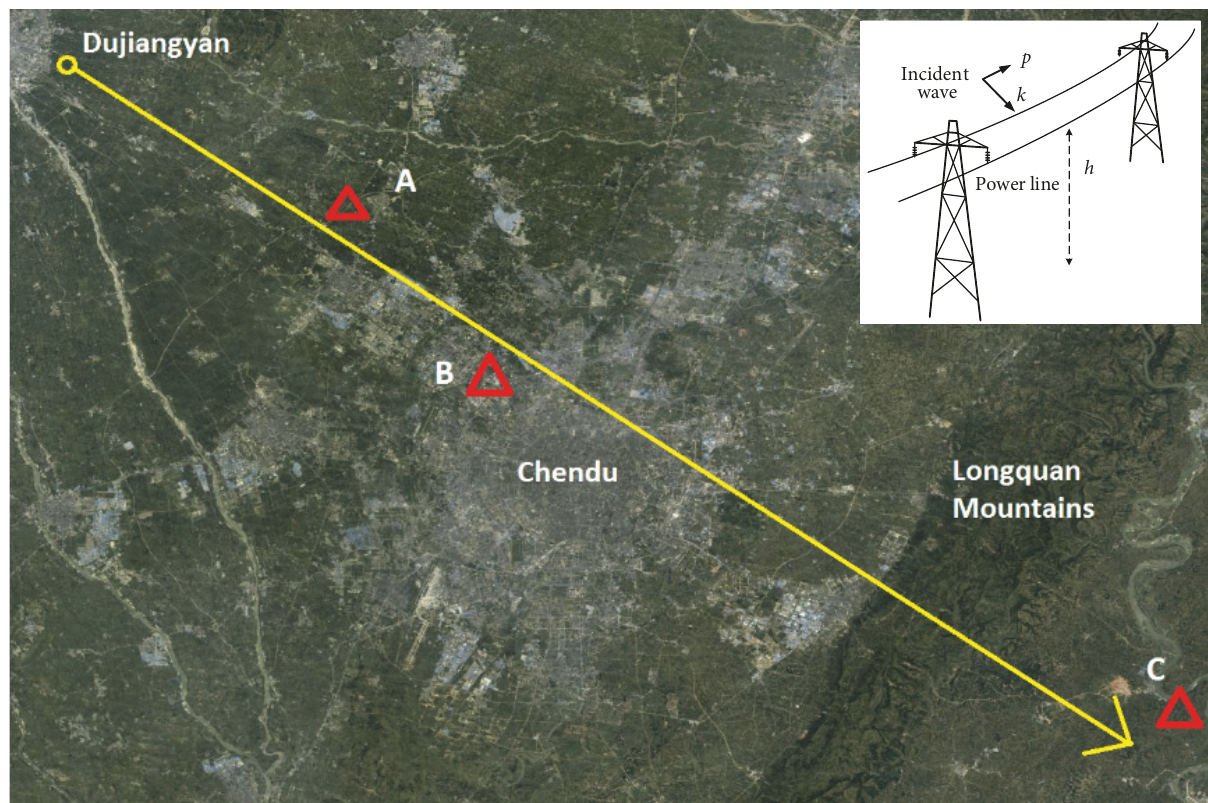
Figure 12: Experiment scene. The concerned power transmission lines are marked as red